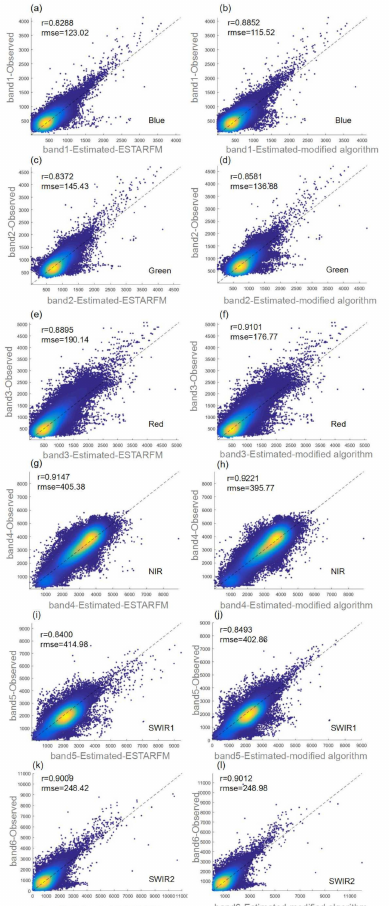
Figure 6. Scatter plots of the actual reflectance values and estimated values by the ESTARFM (left column, a , c , e , g , i , k ) and modified algorithm (right column, b , d , f , h , j , l